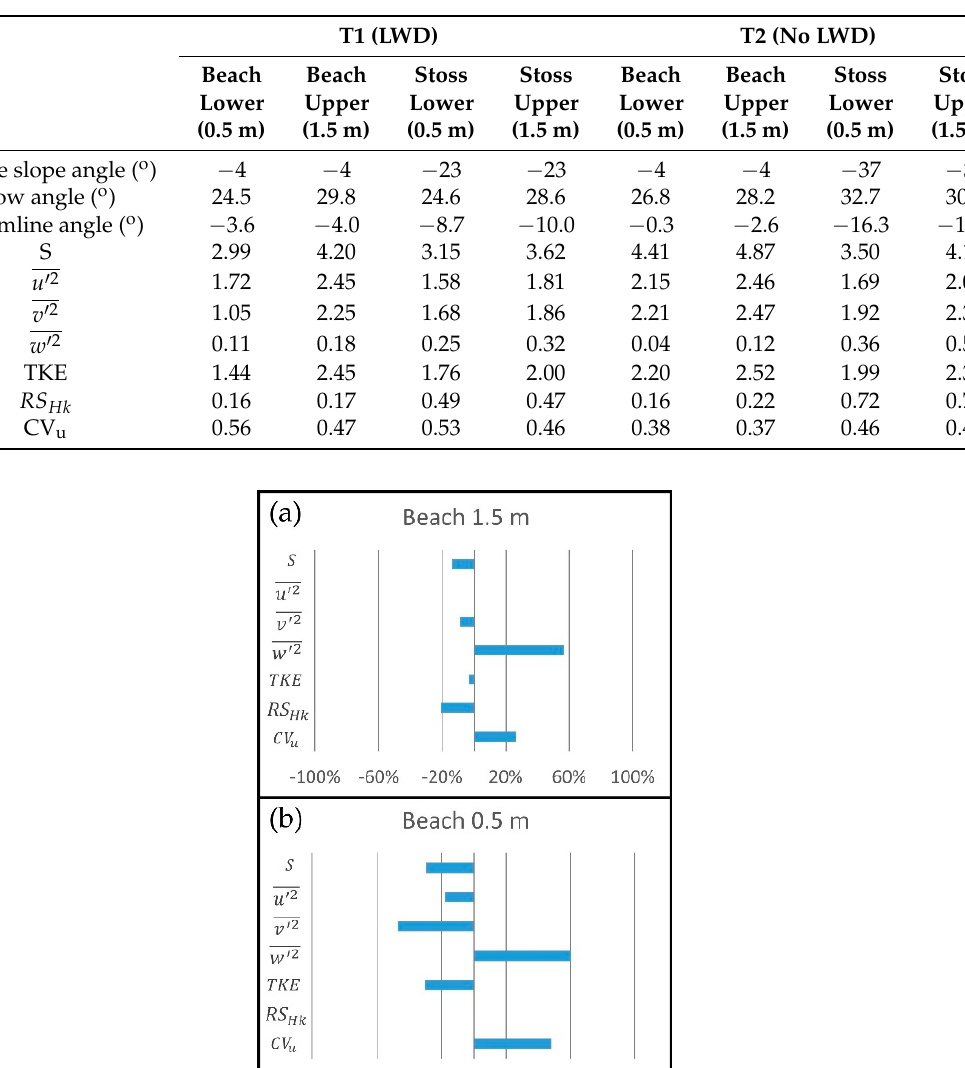
Table 2. Average flow properties for all runs including surface slope angle and incident flow